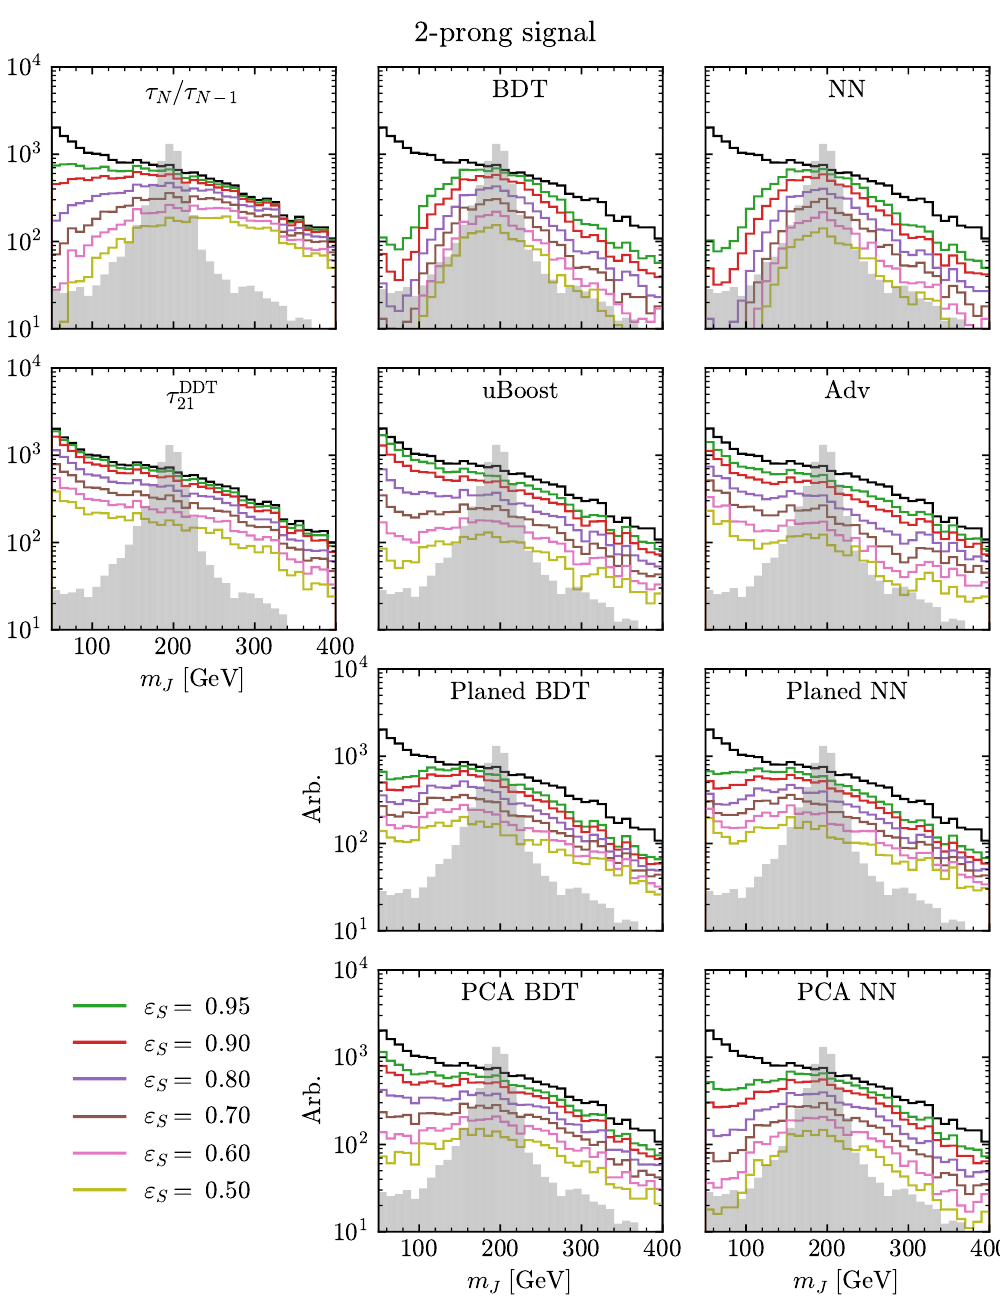
Figure 18: Comparison of all decorrelation methods to the benchmarks for the 2- prong signal. τ